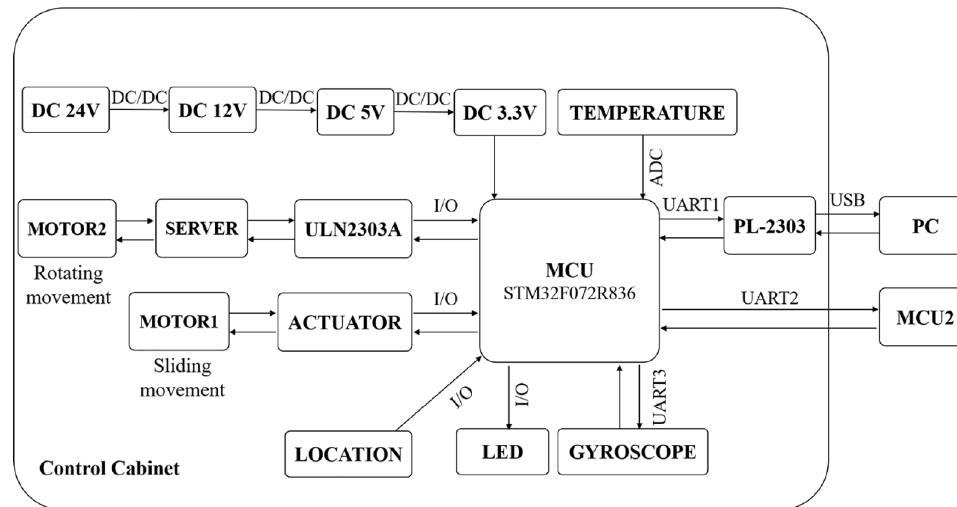
Figure 6 Block diagram of control cabinet of experimental